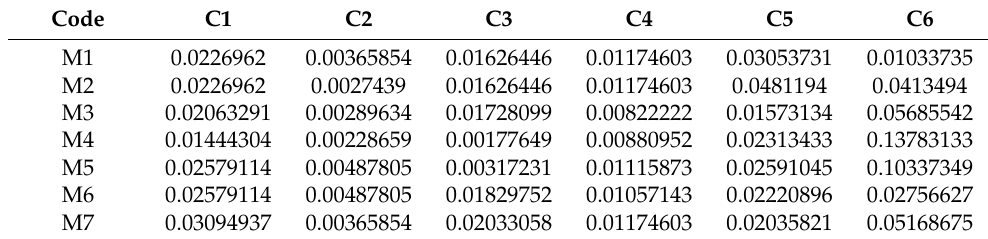
Table 23. Standardized weight matrix COPRAS Vij.